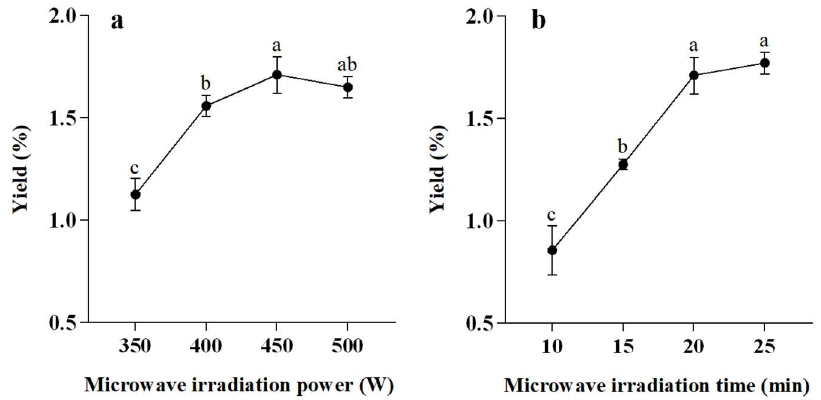
Figure 2. The effect of microwave irradiation ( a ) power and ( b ) time on the yield of L. cubeba essential oil. Yield with the same letter are not significant at p < 0.05, which are presented as the means ± standard deviation of the triplicate.